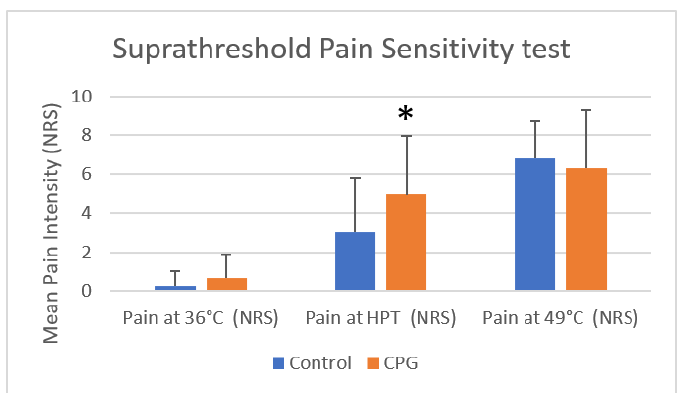
Figure 4. Comparison of mean ± SD pain sensitivity in suprathreshold tests in the control group and the CPG (NRS at 36 °C, mean heat pain threshold, and 49 °C) using Mann–Whitney U test (* p < 0.05). HPT, heat pain threshold; NRS, numeric rating scale; SD, standard deviation. The results for the suprathreshold tests demonstrated significant differences between the control group and the CPG at HPT but not at 36 °C or 49 °C (Mann–Whitney U test).